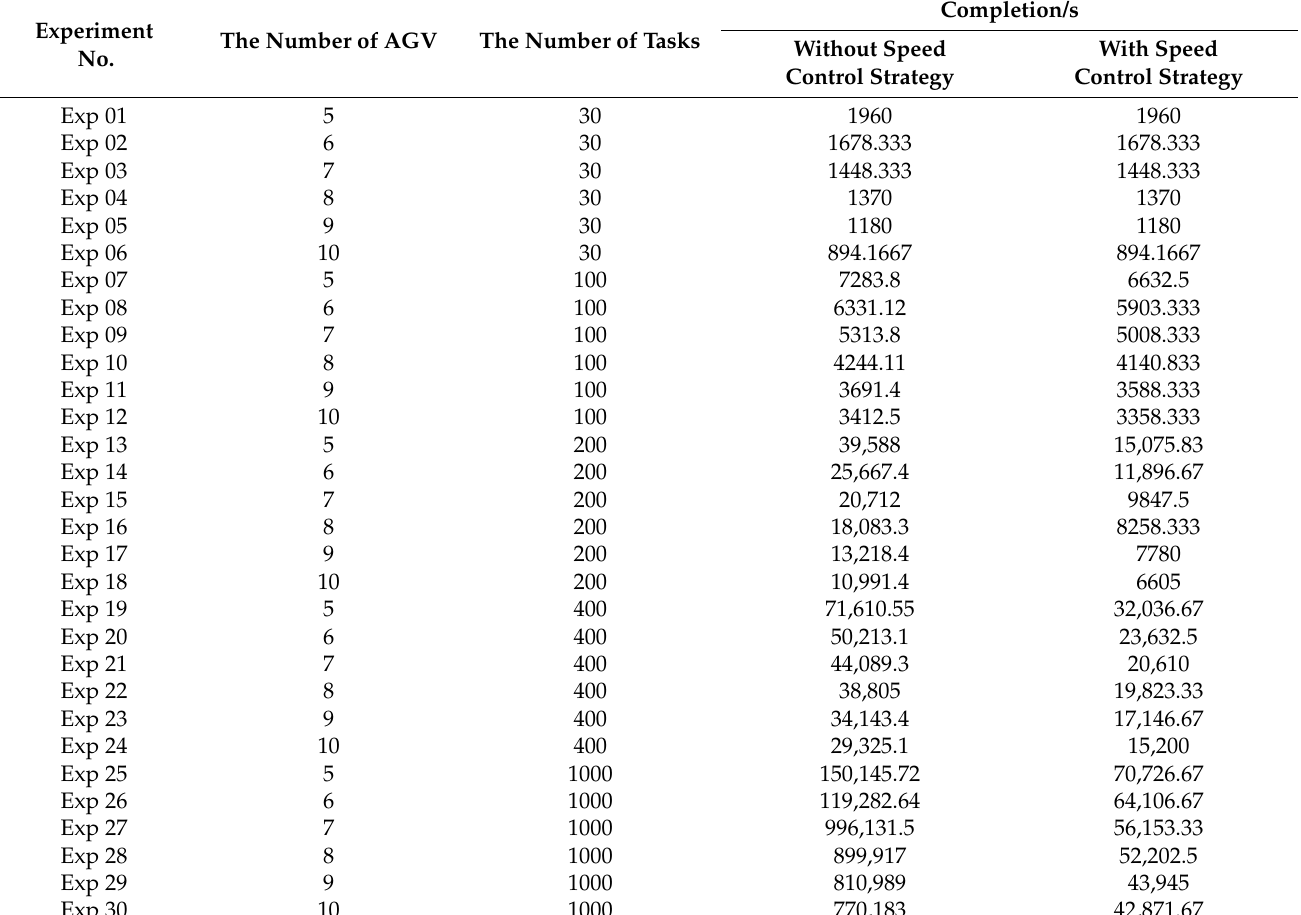
Table 7. Comparison of AGV makespan time with and without speed control strategy.